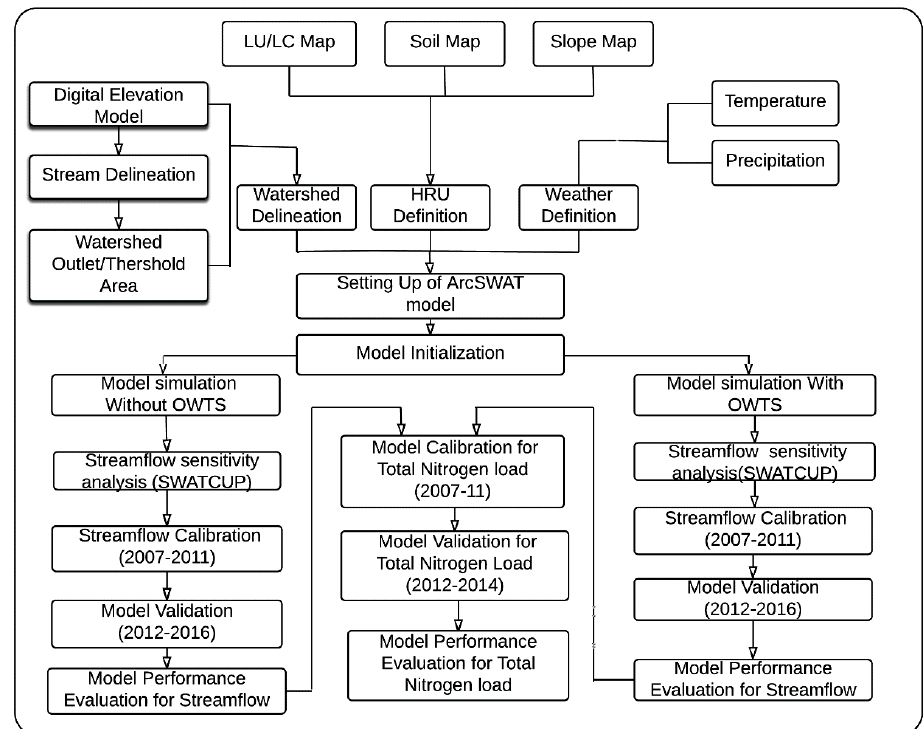
Figure 2. Flowchart of SWAT Model Development and Calibration Scheme.